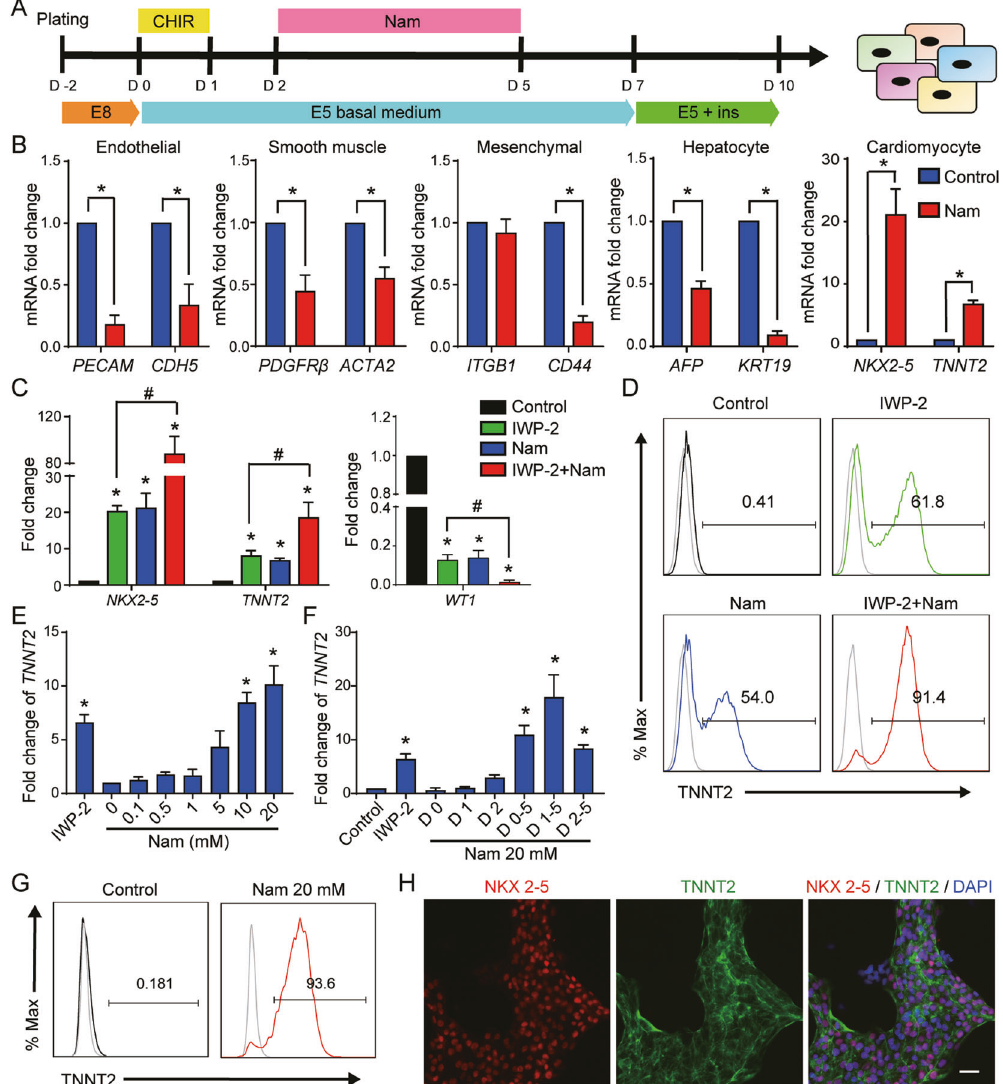
Fig. 1 Effect of nicotinamide on mesodermal differentiation. A The schematic diagram showing the protocol of mesoderm differentiation with or without nicotinamide. hESCs were seeded in matrigel-coated plates for 2 days, treated with CHIR99021 (CHIR) 5 μ M for 1 day, and then treated with or without nicotinamide 10 mM from day 2 to day 5. Differentiated cells were harvested for analyses at day 10. B Analyses of mRNA expression levels of PECAM , CDH5 , PDGFRB , ACTA2 , ITGB1 , CD44 , AFP , KRT19 , NKX2-5 , and TNNT2 in the neutral condition with or without nicotinamide treatment. Blue, control; red, nicotinamide 10 mM. C Analyses of mRNA expression levels of NKX2-5 , TNNT2 , and WT1 in cardiac differentiation. Black, Control; green, IWP-2 3 μ M; blue, Nicotinamide 10 mM; red, IWP-2 3 μ M and nicotinamide 10 mM. D The percentage of TNNT2-positive cells was determined by fl ow cytometry. The results shown are representative of three independent experiments. Gray line indicates the level of isotype control. E Dose-dependent effect of nicotinamide on the gene expression of TNNT2 in cardiac differentiation. Nicotinamide or IWP-2 was added from day 2 to day 5. Data shown are normalized with Nam 0 (* p < 0.05 compared with Nam 0). F Timing effect of nicotinamide on the gene expression of TNNT2 in cardiac differentiation. G After 13 days of differentiation, TNNT2-positive cells were determined by fl ow cytometry. Nicotinamide (Nam) at 20 mM added from day 1 to day 5. Gray line indicates the level of isotype control. The results shown are representative of 3 independent experiments. H Confocal microscopy images showing immunostaining of NKX2.5 and TNNT2 in differentiated cells treated by nicotinamide (Nam) 20 mM at day 13 of differentiation. Scale bar, 20 μ m. Data shown are mean ± SD of three independent experiments (* p < 0.05 compared with control, # p < 0.05 compared with